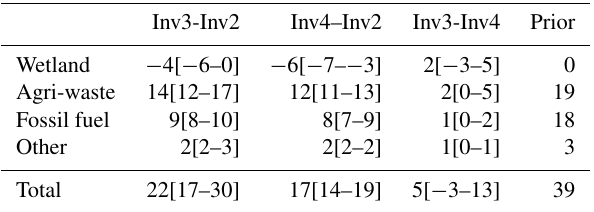
Table 6. Global sectoral emission changes (Tgyr − 1 ) from the early 2000s (July 2000–June 2002) to the late 2000s (July 2007– June 2009) (mean and the min–max